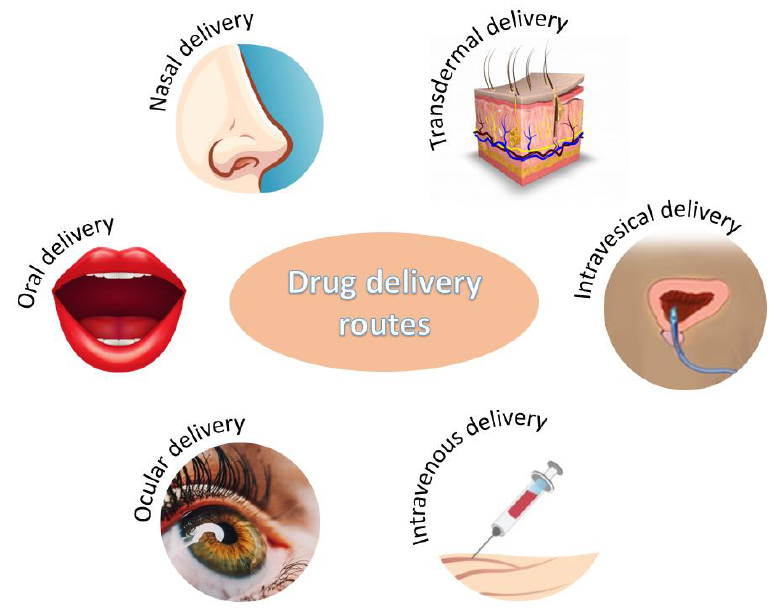
Figure 3. Administration routes for chitosan-alginate-based drug delivery systems.